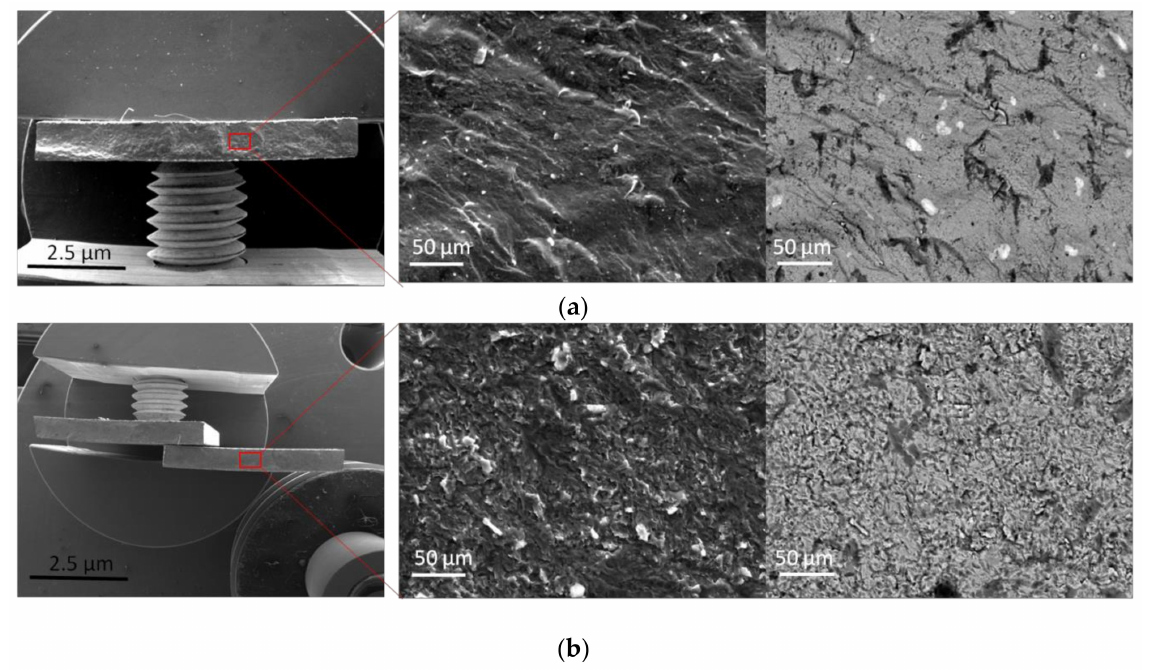
Figure 12. Factography of titanium aluminide samples: ( a ) Morphology of the fracture surface of sample MA-20; ( b ) Morphology of the fracture surface of sample MA-180.